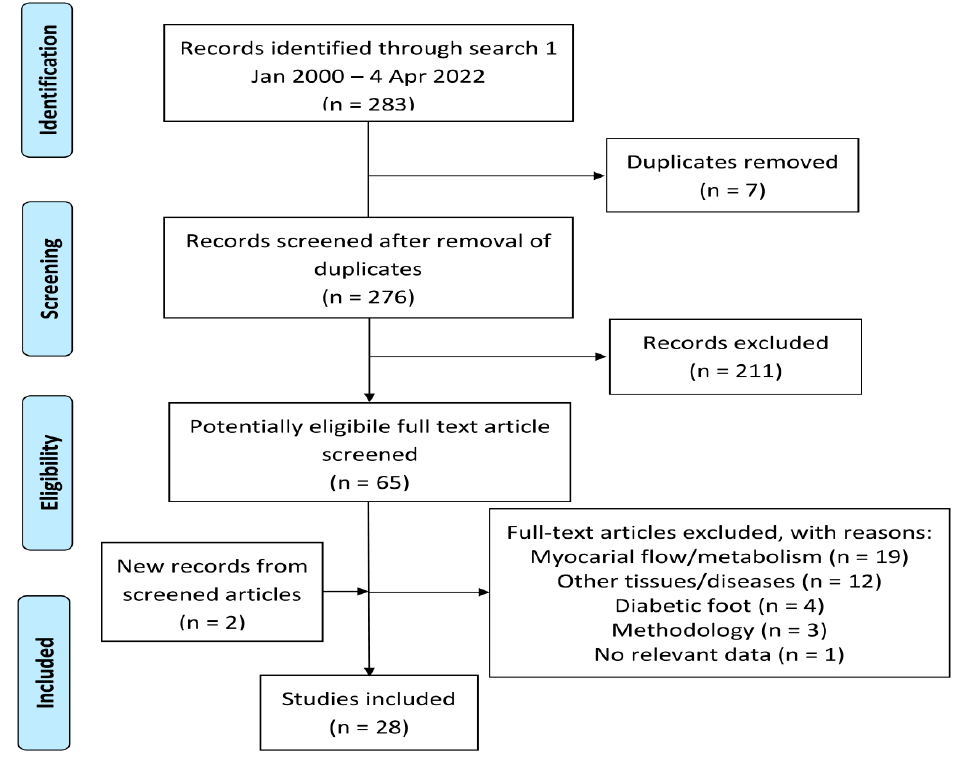
Figure 1. Modified PRISMA diagram showing literature selection.